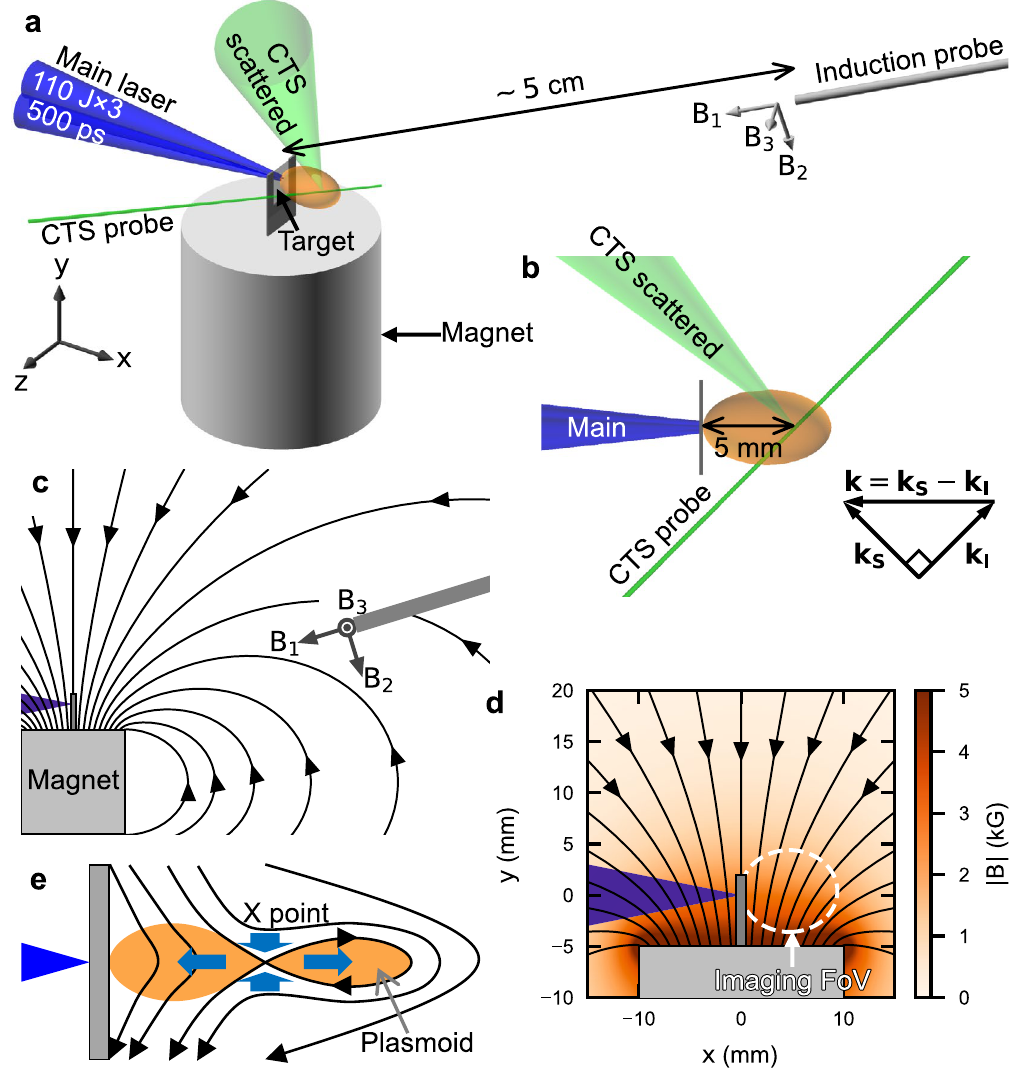
Figure 1. Experimental setup. ( a ) Schematic of the experiment. The three beams forming the main laser, shown in blue, irradiate a plastic (CH) foil target of thickness 10 µ m . The laser operates at a wavelength of 351 nm with pulse duration of 500 ps and 110 J/beam, the focal spot diameter is 300 µ m . Each focal spot is separated by 430 µ m to obtain collimated plasma flow on the rear-side of the plastic target 31 . The laser propagates along the x -axis, the y and z axes define the orthogonal vertical and horizontal directions respectively. The target chamber is filled with either nitrogen gas of 5 Torr (case1) or e-4 Torr (case2). The upstream of target plasma is same in both cases. A permanent magnet placed below the target applies a static near-perpendicular magnetic field across the interaction region, with magnetic field components ( B 1 , B 2 , B 3 ) at the location of a three-axis induction probe placed at ∼ 5cm from the target of ( 43, 19, 0 ) G . This probe measures the time-dependent changes in the magnetic field ( ˙ B 1 , ˙ B 2 , ˙ B 3 ) is tilted at ( 30 ◦ , 73 ◦ , 114 ◦ ) with respect to the ( x , y , z ) axes as indicated by the gray arrows. ( b ) Top view of the experiment showing in green the CTS probe beam. This beam operates at a wavelength of 532 nm is focused 5 mm behind the target, with scattered light collected at 90 ◦ . The measured k is parallel to x , the main laser propagation direction. ( c ) The configuration of the initial magnetic field. ( d ) Enlarged view of ( c ). The magnetic field strength at the target is ∼ 3kG . The dashed white ellipse represents the field of view for imaging diagnostics. ( e ) Schematic illustration of the reconnection in our setup. The collimated plasma flow distorts the near-perpendicular magnetic field and forms the X point and plasmoid. The blue arrows indicate the inflows and outflows of the magnetic